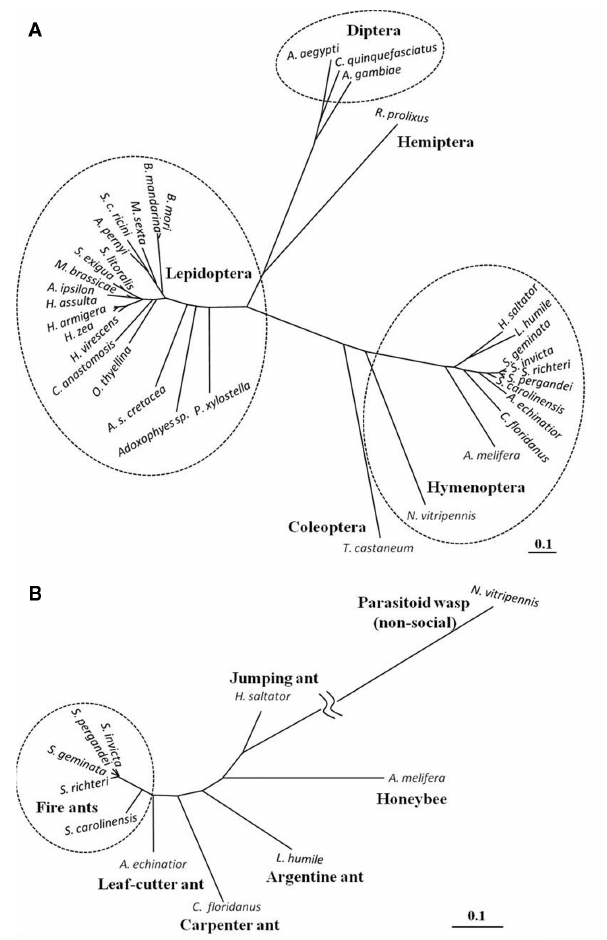
FIGURE 5 | Phylogenetic tree based on the entire amino acid sequence from PBAN/pyrokinin genes known from insect orders (A) and hymenoptera (B). The tree was made using Genetyx-Tree software (ver. 10) with the neighbor-joining distance phylogram method using